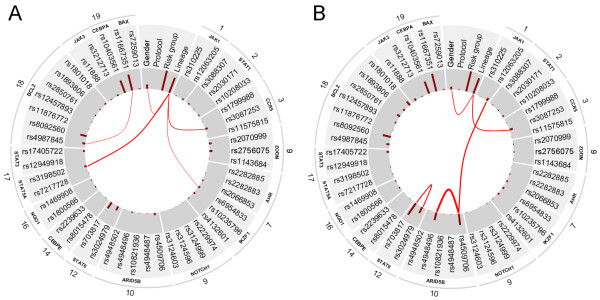
Interactions in event-free and overall survival according to the BN-BMLA method. The figure shows the magnitude of interactions (red curved lines) between the variables in the event-free survival (A panel), and in the overall survival (B panel) according to the BN-BMLA method. See Methods for the computation of interaction. The width of the curved lines is proportional to the strength of the effect. The a posteriori probability of the strong relevance of the variables is proportional to the length of the dark red columns next to the variable in the inner gray colored ring. The corresponding genes and chromosomes of the SNPs are shown on the outer ring.